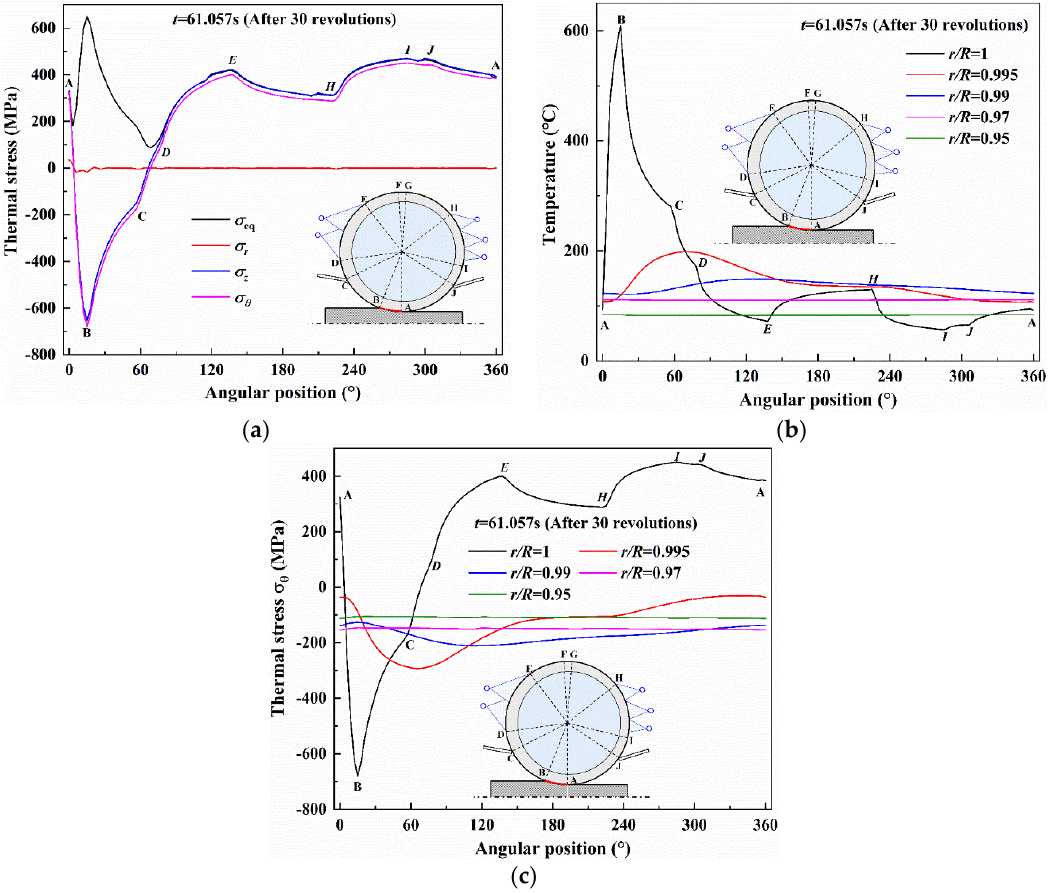
Figure 2. Distribution of temperatures and thermal stresses as a function of the angular position after 30 revolutions: ( a ) temperatures with the different depths, ( b ) thermal stress components at the roll surface; ( c ) thermal stresses with the different depths.